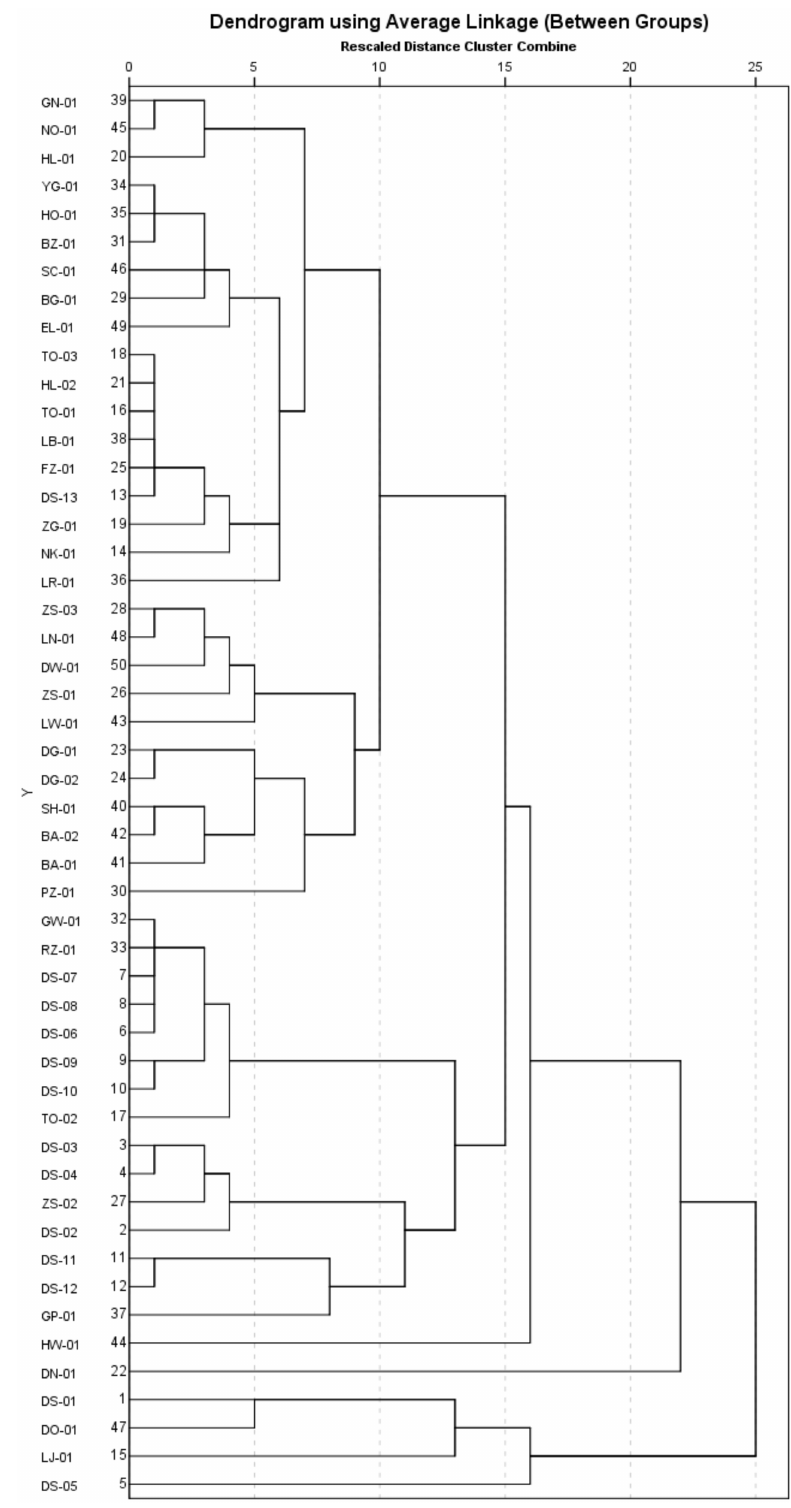
Figure 2. Feature clusters of high riverbanks in Taiwan based on the Comfortable Water Environment Rest Assessment